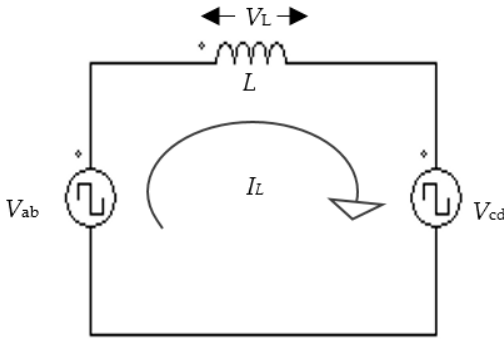
Figure 3. Equivalent circuit of phase-shift control.